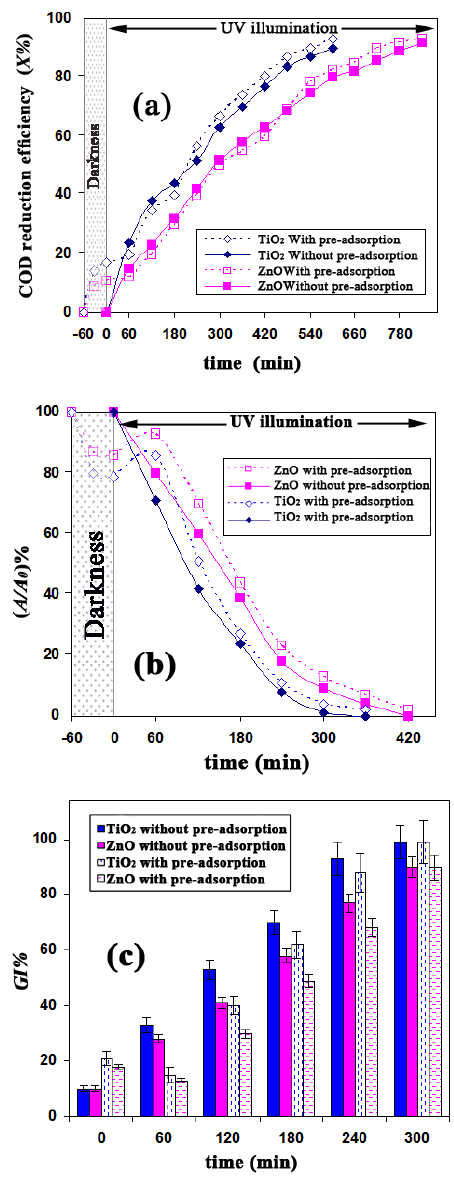
Figure 3. E ff ects of pre-adsorption period on ( a ) mineralization; ( b ) dearomatization; and ( c ) detoxification of FB1 by UV-TiO 2 and UV-ZnO processes; [FB1] 0 = 50 mg / L, [TiO 2 ] = 0.8 g / L, [ZnO] = 1.2 g / L, T = 25 ◦ C and pH =